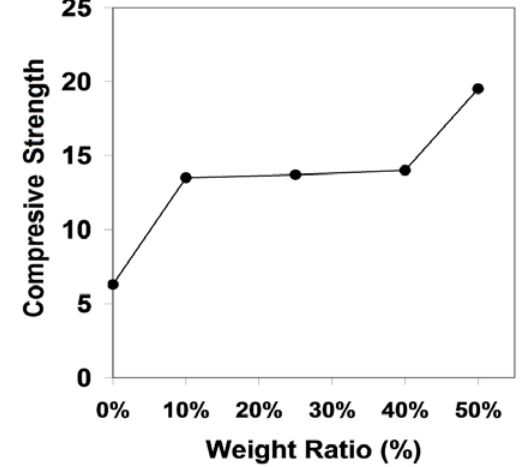
Fig. 7: Compressive strength of the prepared mortars with increased weight ratio of the cockles shells powder in the